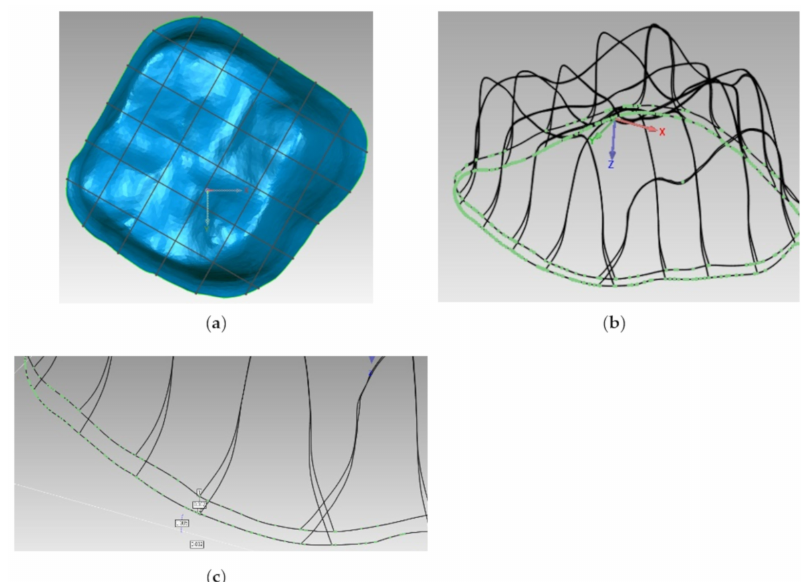
Figure 4. Representation of the known points for the measurement comparison with the pattern line and IOS target line: chromatic map of direct scan with intraoral scanner ( a ); inward moving (blue) and outward moving (red) of displacement between overlapped structures ( b ), whereas an absence change was indicated by a green colour ( c